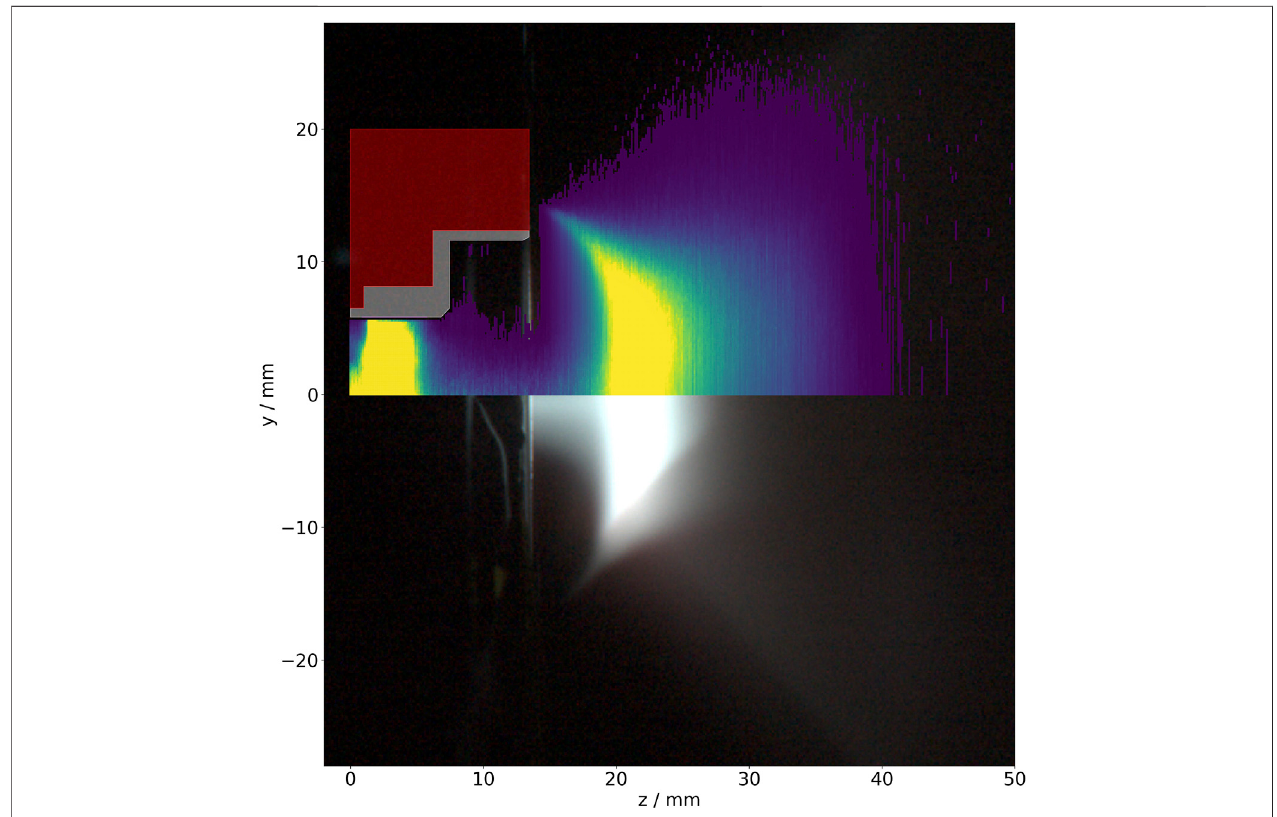
FIGURE 9 | Optical emission measurement of the MS4 overlaid on the upper half with the Abel-transformed, simulated, total electron-Xenon excitation collision distribution.